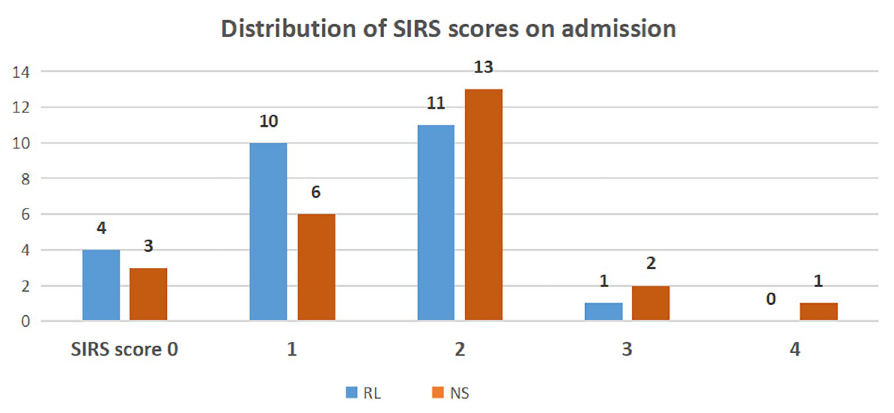
Fig 2. Distribution of SIRS score in the study population. RL: Ringers lactate, NS: Normal Saline.